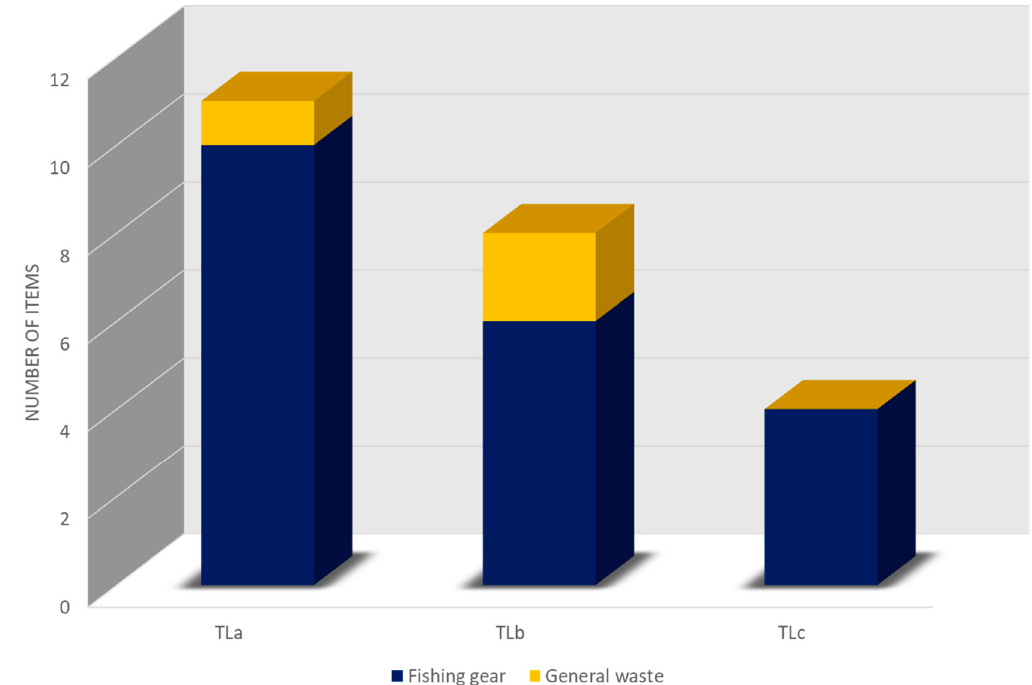
Figure 5. Composition of marine litter groups in the three transects.